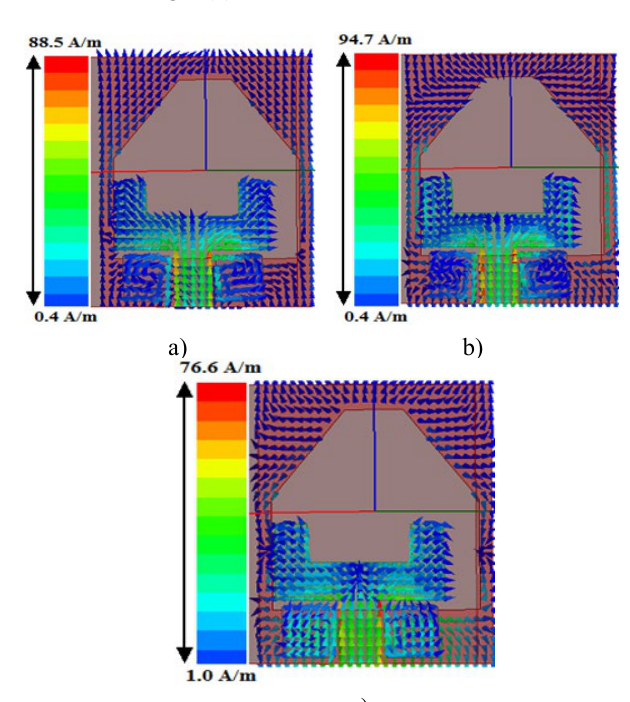
Fig. 3. Surface current density distributions of the proposed antenna at resonating frequencies a) 5.7 GHz; b) 8.2 GHz; c) 11.2